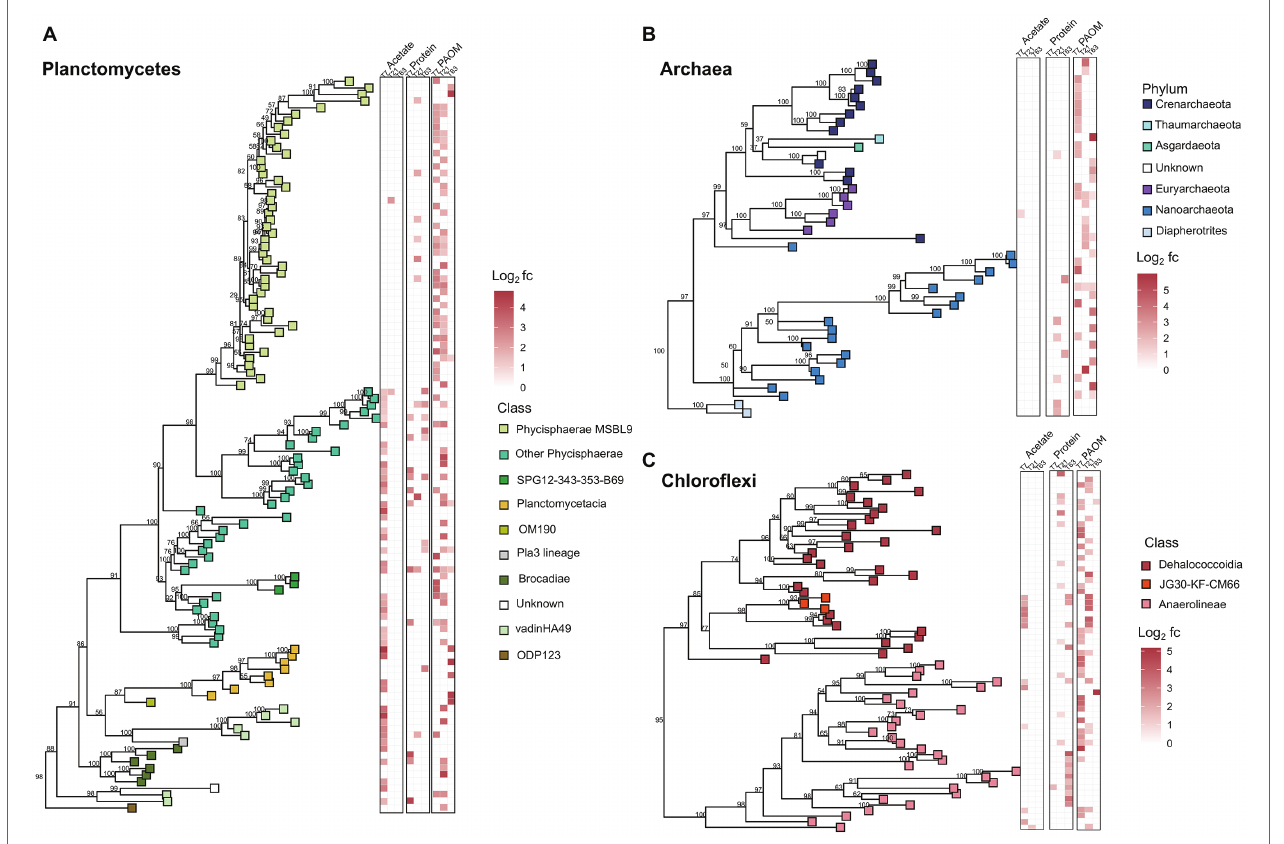
FIGURE 4 | Phylogenetic trees showing the taxonomic relationship of the 16S rRNA gene fragments of the OTUs of the taxonomic groups with most labeled OTUs in the DNA-SIP analysis of organic matter (OM) degradation. (A) labeled OTUs of Planctomycetes, (B) labeled OTUs of Archaea, and (C) labeled OTUs of Chloroflexi. Heatmaps show the log2 fold change calculated by HRSIP compared across the different treatments and sampling timepoints. Colors correspond to class level or phylum level taxonomic group as defined by sequence analysis. Values shown in tree are bootstrap support